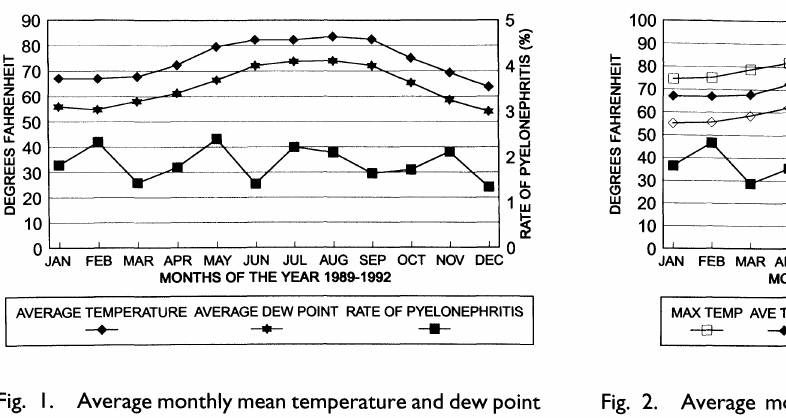
Fig. I. Average monthly mean temperature and dew point compared with monthly rate of pyelonephritis per number of deliveries during the 4-year period 1989-1992.